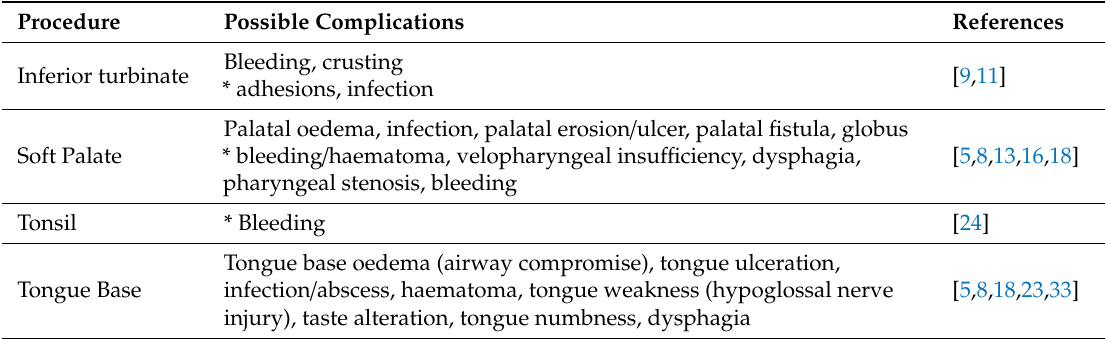
Table 1. Complications for radiofrequency surgery. * Not specifically reported, but possible from author’s